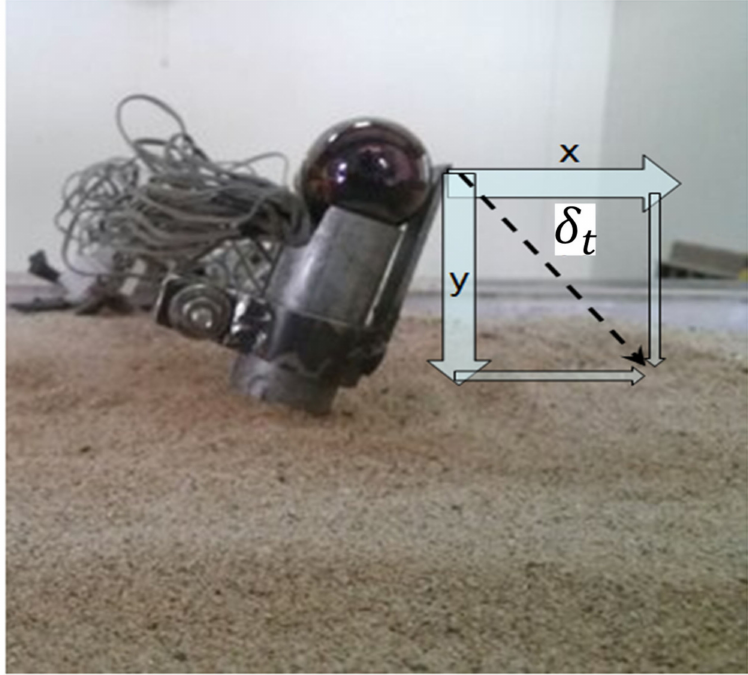
Figure 9. Total displacement of pile head.